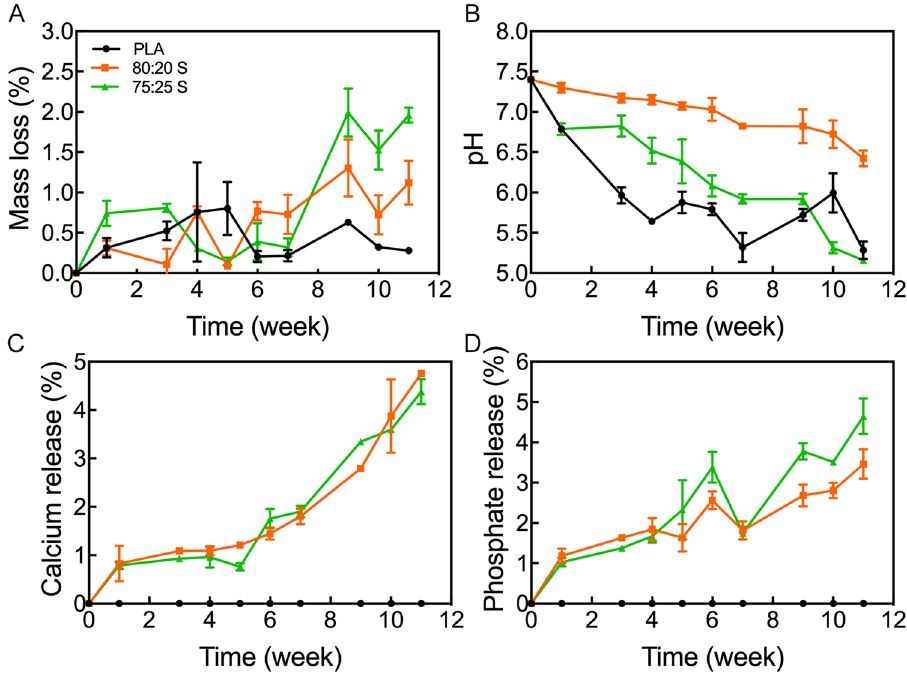
Figure 1. In vitro analysis of ( A ) mass loss, ( B ) pH change, ( C ) calcium and ( D ) phosphate release for 3D-printed scaffolds. Error bars indicate one standard deviation above and below the